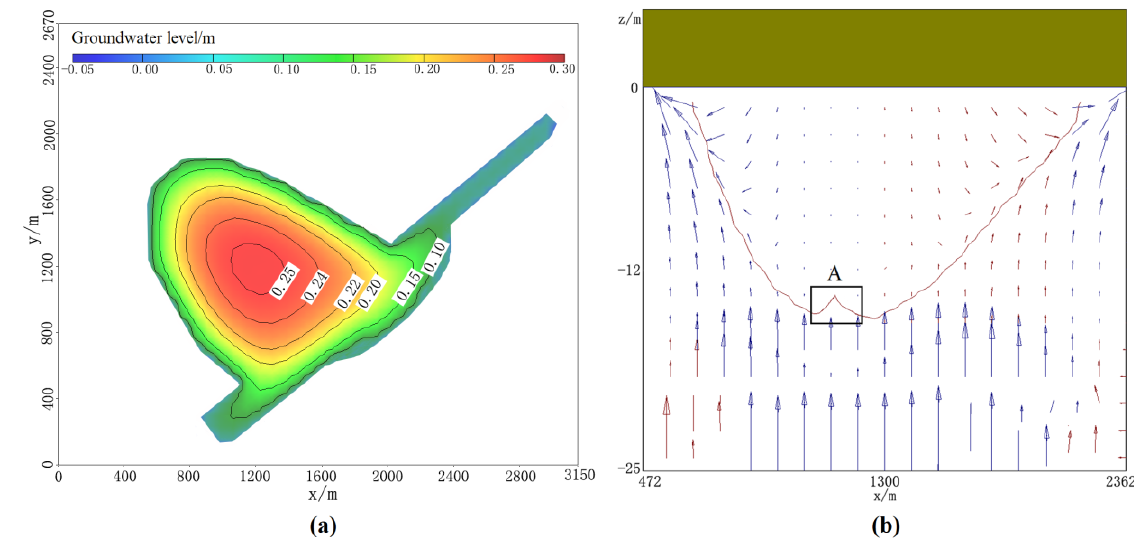
Figure 5. ( a ) Water head distribution above sea level of the island; ( b ) velocity and direction of groundwater on the island.